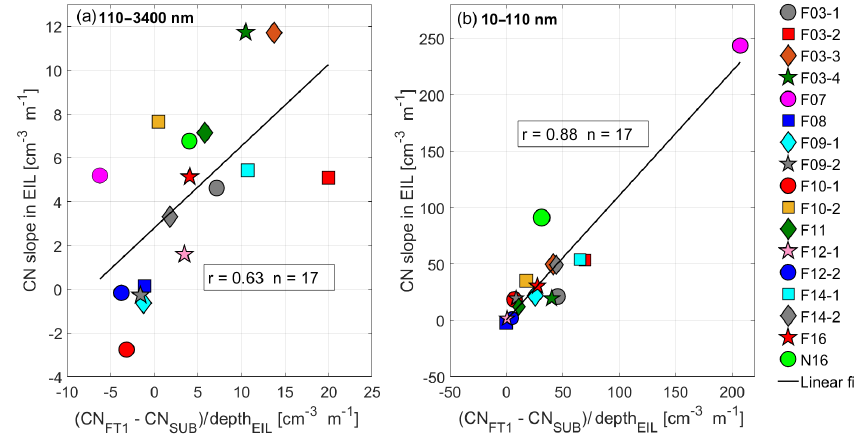
Figure 8. Relationship between the slope of particle number concentration (CN) in the EIL and number concentration differences between the FT1 and SUB layers. Results are shown for two particle diameter ranges: (a) 110–3400nm and (b) 10–110nm. The x axis is normalized by the EIL depth to account for reduced slopes when the EIL is